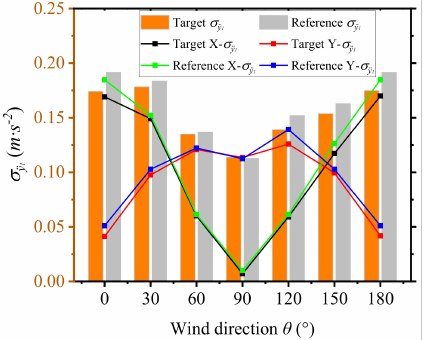
Figure 17. Maximum value of acceleration of the building model along the vertices of the body